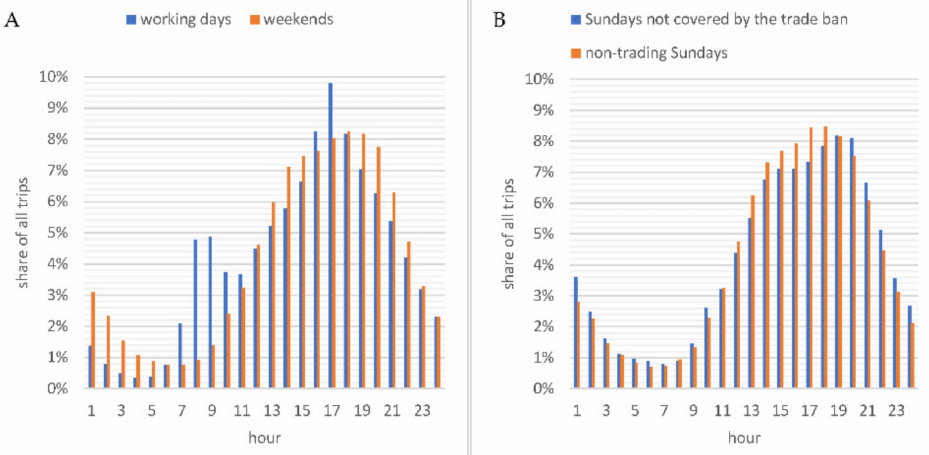
Figure 8. Time distribution of ŁPB trips divided into workdays and weekends ( A ) and non-trading and trading Sundays ( B ) in Ł ó d´z in 2018. Source: own elaboration based on data from the Ł ó d´z City